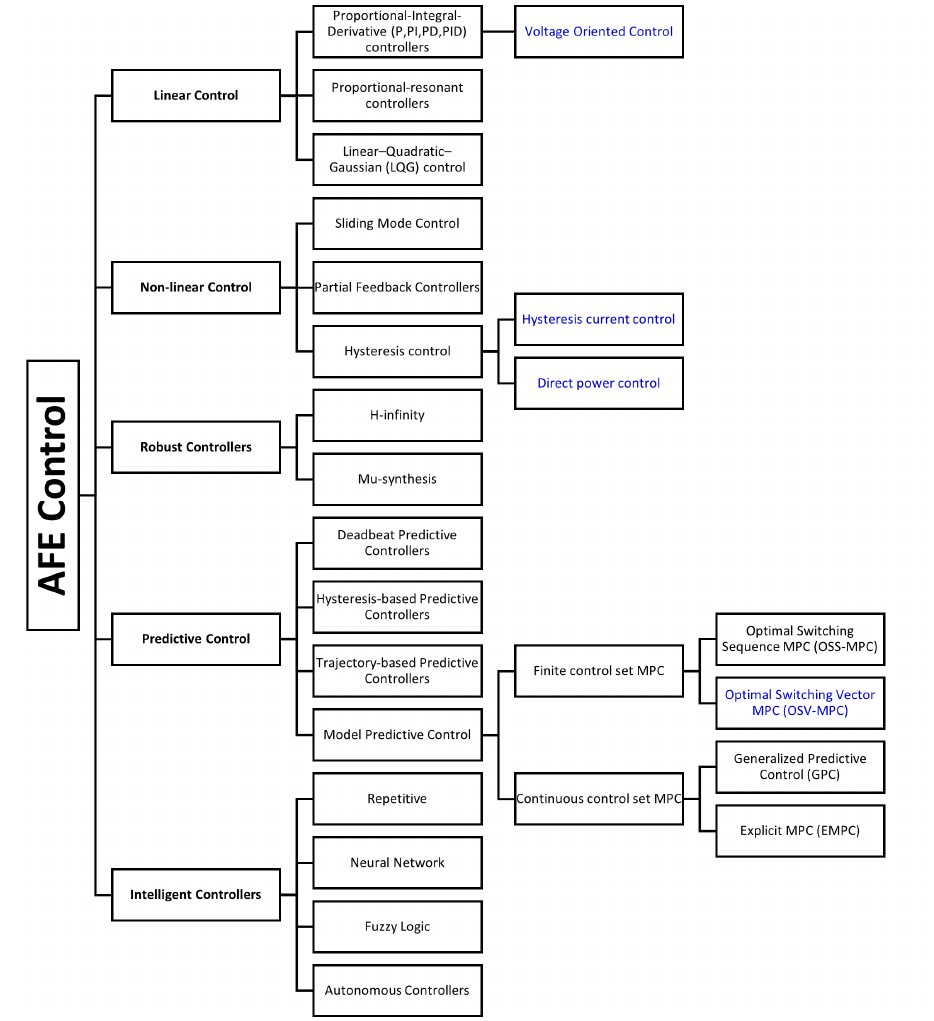
Figure 23. Classification of control systems for AFE rectifiers in EV charging